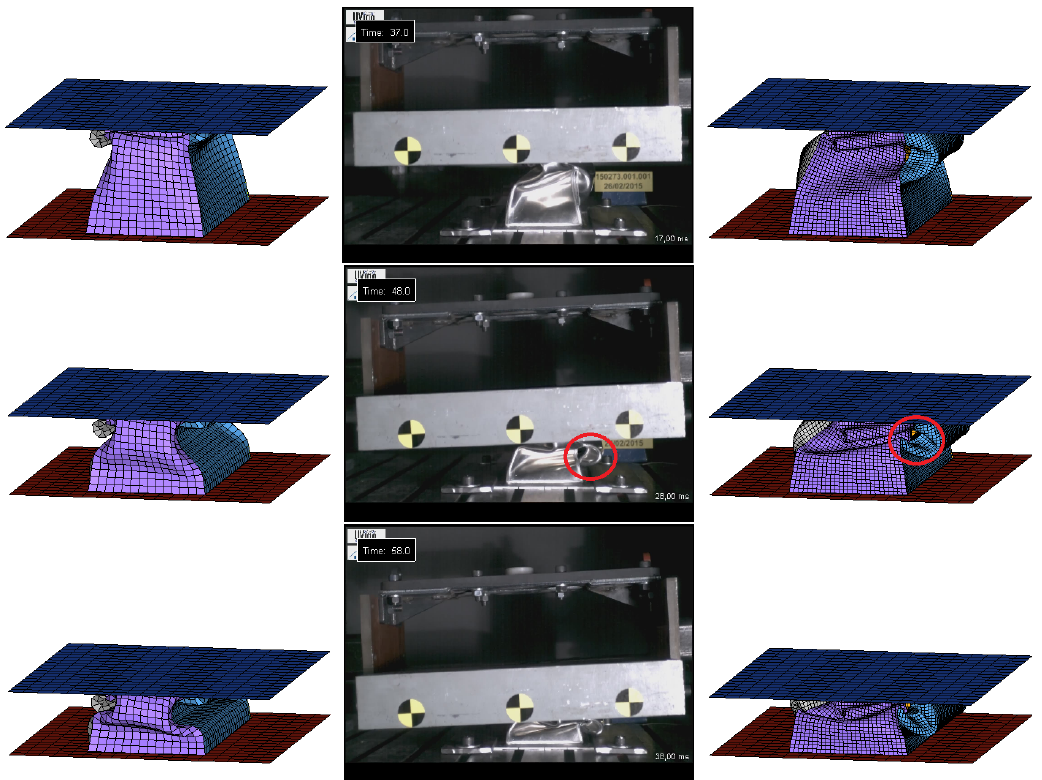
Figure 6. Images of the real test ( center ), and two simulations with a coarse ( left ) and fine ( right ) mesh. The snapshots were taken at at 37, 48 and 58 ms (from top to bottom). The opening of the welding is highlighted both in the real test and the